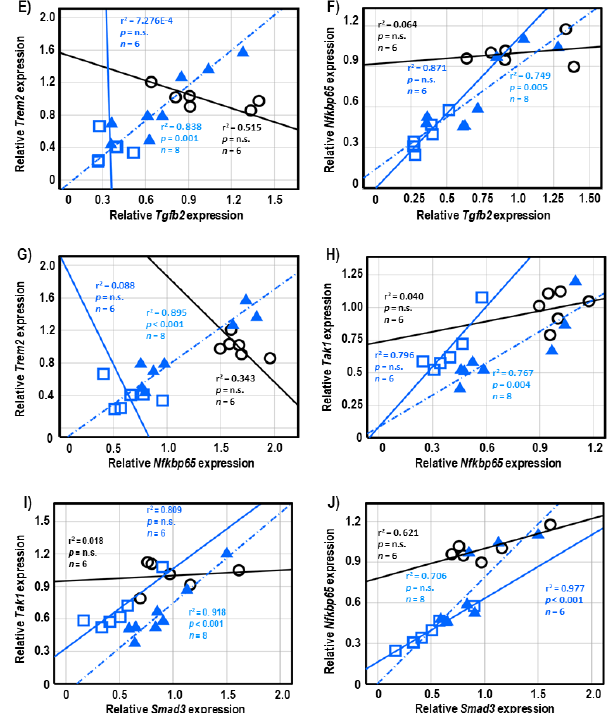
Figure 6. Spearman correlational analysis of genes showing significant differences after H.E. treatment. ( A – D ) Scatter plots represent significant correlations of the gene expression of Tgfb1 with ( A ) Tgfb2 , ( B ) Smad3 , ( C ) Nfkbp65 , and ( D ) Tak1 . ( E , F ) Scatter plots represent correlations of the gene expression of Tgfb2 with ( E ) Trem2 and ( F ) Nfkbp65 . ( G , H ) Scatter plots represent correlations of the gene expression of Nfkbp65 with ( G ) Trem2 and ( H ) Tak1 . ( I , J ) Scatter plots represent correlations of the gene expression of Smad3 with ( G ) Tak1 and ( H ) Nfkbp65 . Indicators: Non-3-AP SAL group, 3-AP SAL group, 3-AP H.E. group.